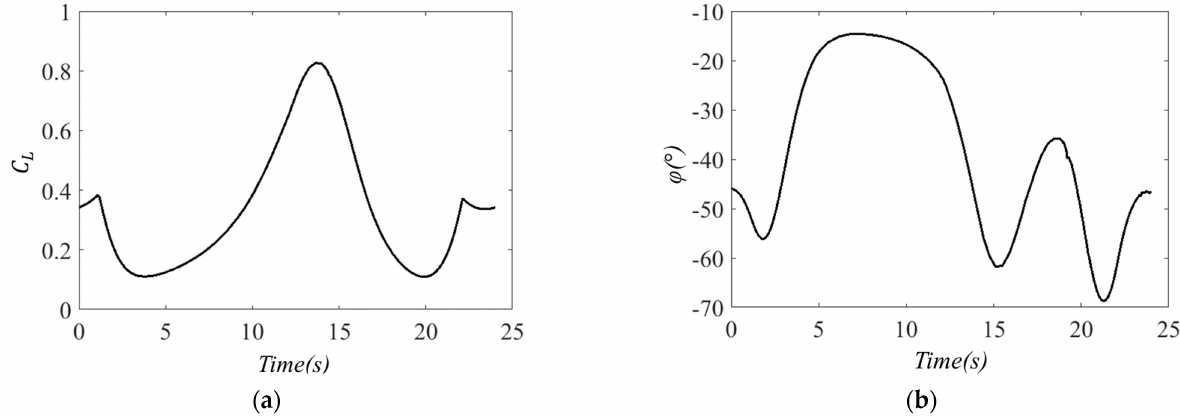
Figure 8. The optimal control curves in CCD of the glider dynamic soaring system: ( a ) C L , ( b ) ϕ